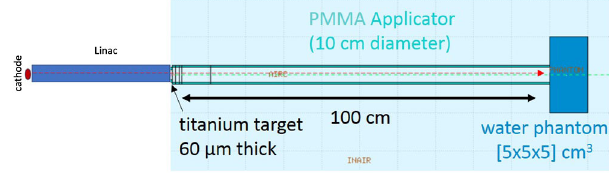
FIG. 12. Sketch of the dose simulation model with FLUKA . A PMMA applicator (with 10 cm diameter) is directly attached to the linac exit and is in air. The target, a 5 × 5 × 5 cm 3 water phantom, is located at 100 cm from the linac.